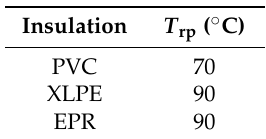
Table 2. Temperature of the permanent regime according to the type of